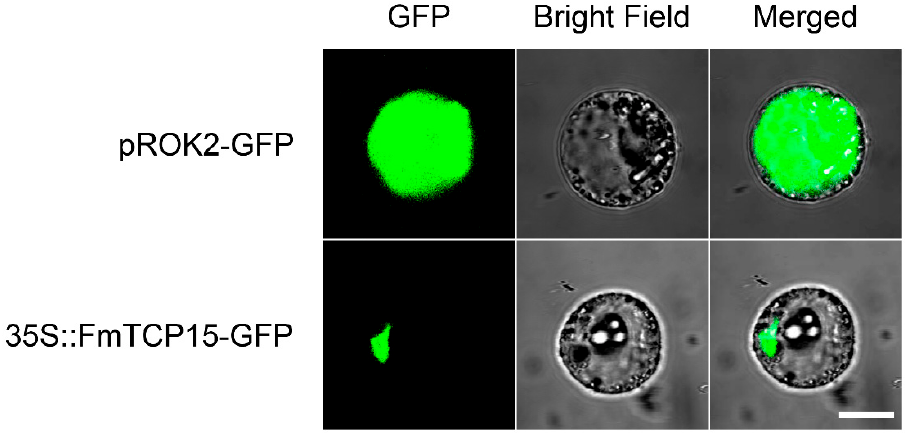
Figure 3. Subcellular localization of FmTCP15. The photographs were taken under darkfield illumination for green fluorescence localization (GFP), bright-field illumination to examine cell morphology (Bright field), and merged-field illumination (Merged). The bar represents 10 μ m.